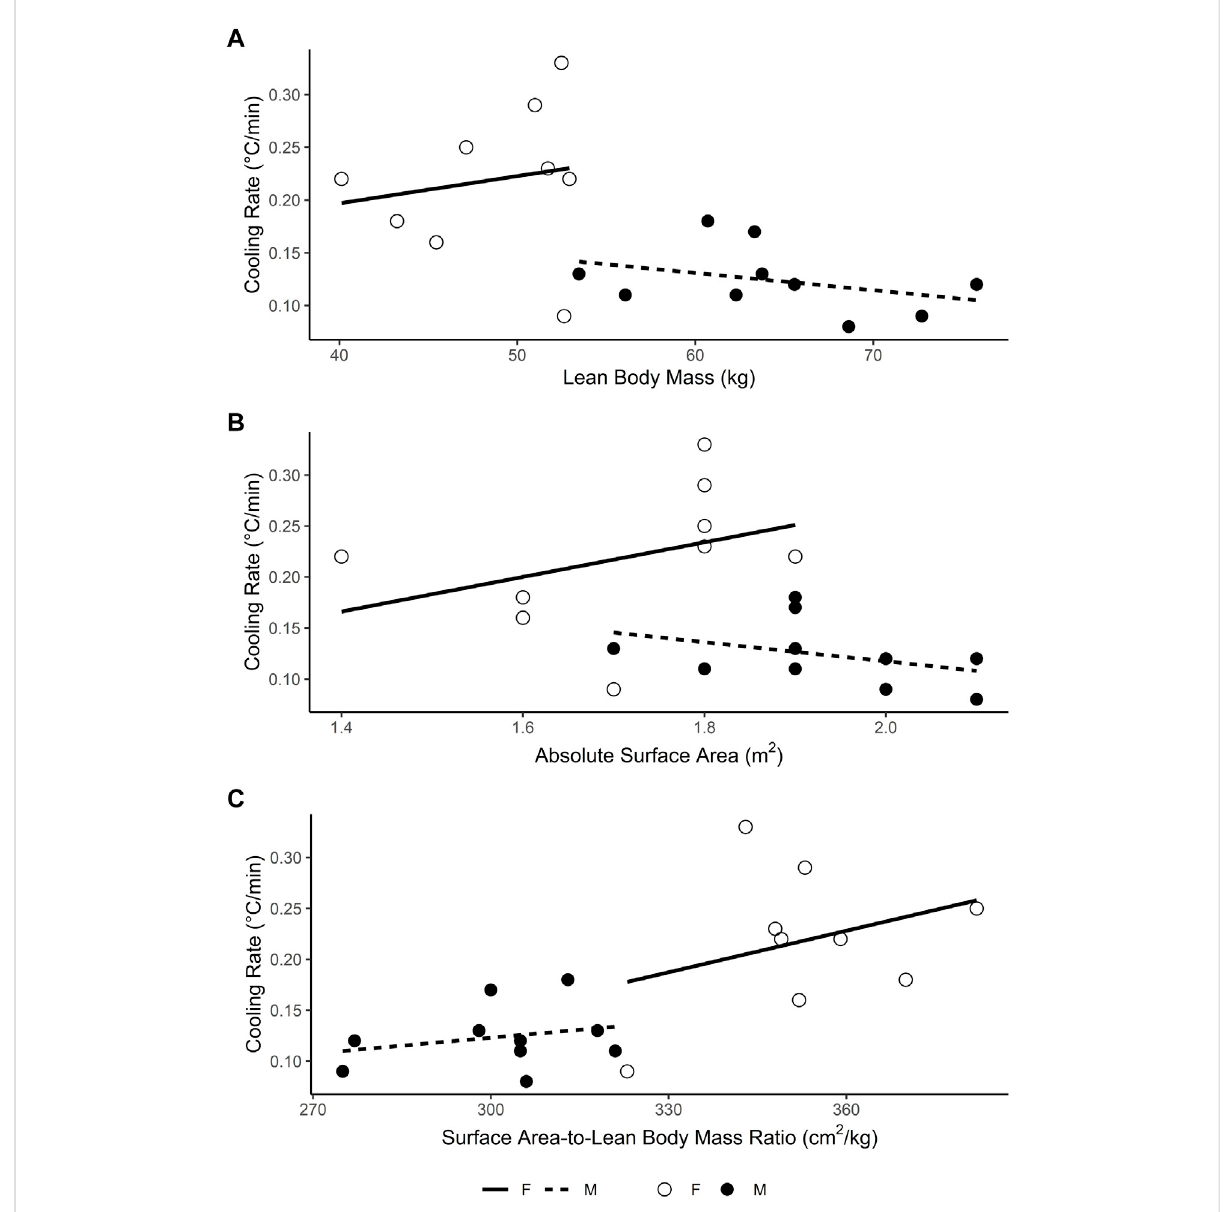
FIGURE 1 Relationship between (A) lean body mass (B) absolute surface area and (C) surface area-to-lean mass ratio and rectal temperature cooling rate in male ( fi lled circles) and female (open circles) participants during cold water immersion (2 ° C) after exercise-induced hyperthermia. Data obtained with permission from Lemire et al.